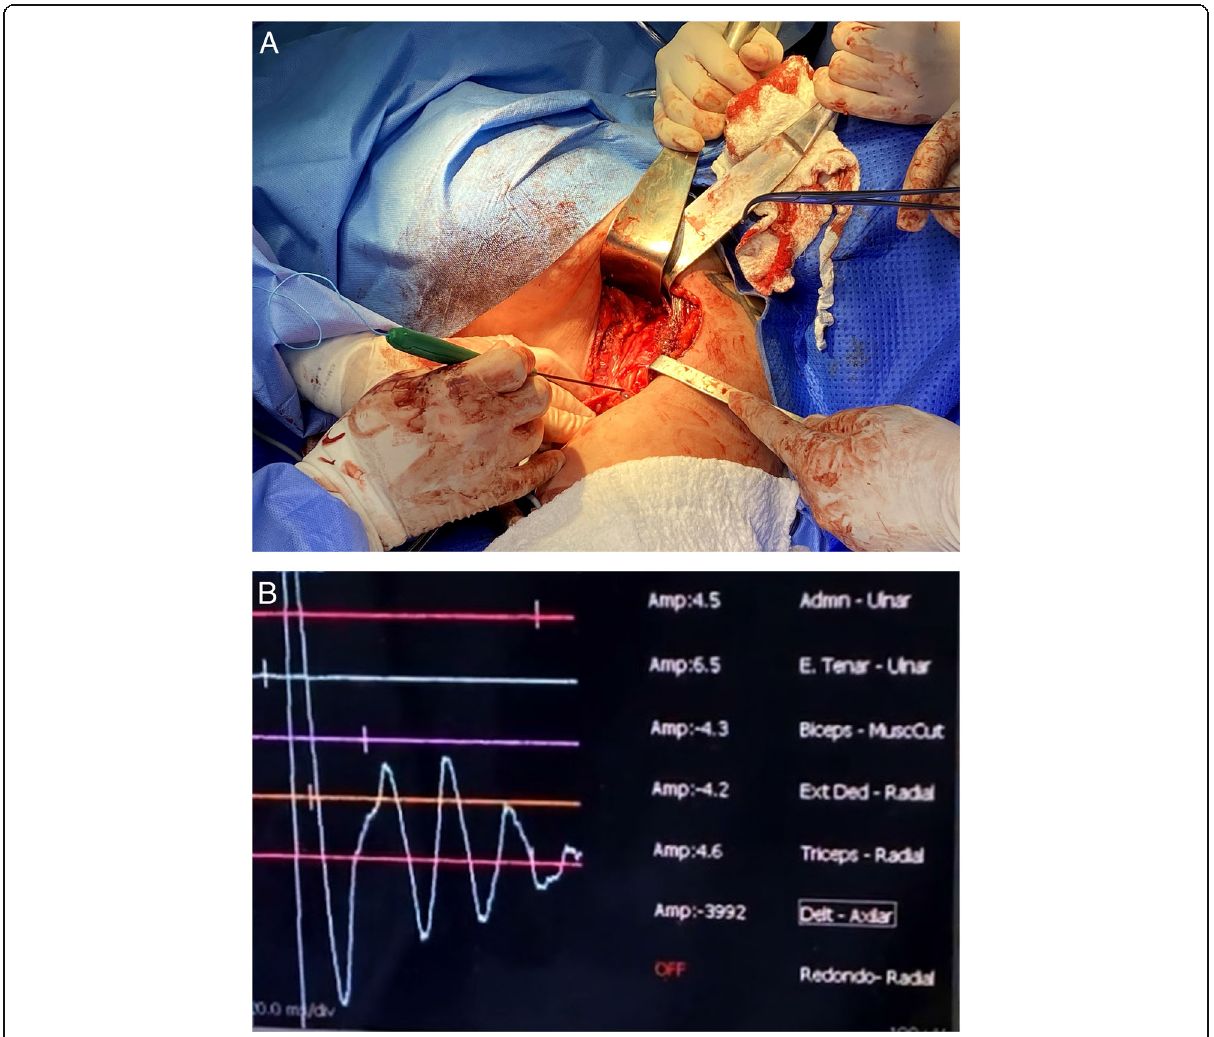
Fig. 3 Intraoperative image of function-preserving surgery with electroneuromyography in real time. A An electrostimulation pen (green arrow) stimulates a structure that raised doubts about its nervous origin (white asterisk). B During monitoring, the muscular contraction of the deltoid was detected, triggering waves (white arrows), proving that the structure in question was the axillary nerve and, therefore, should not be